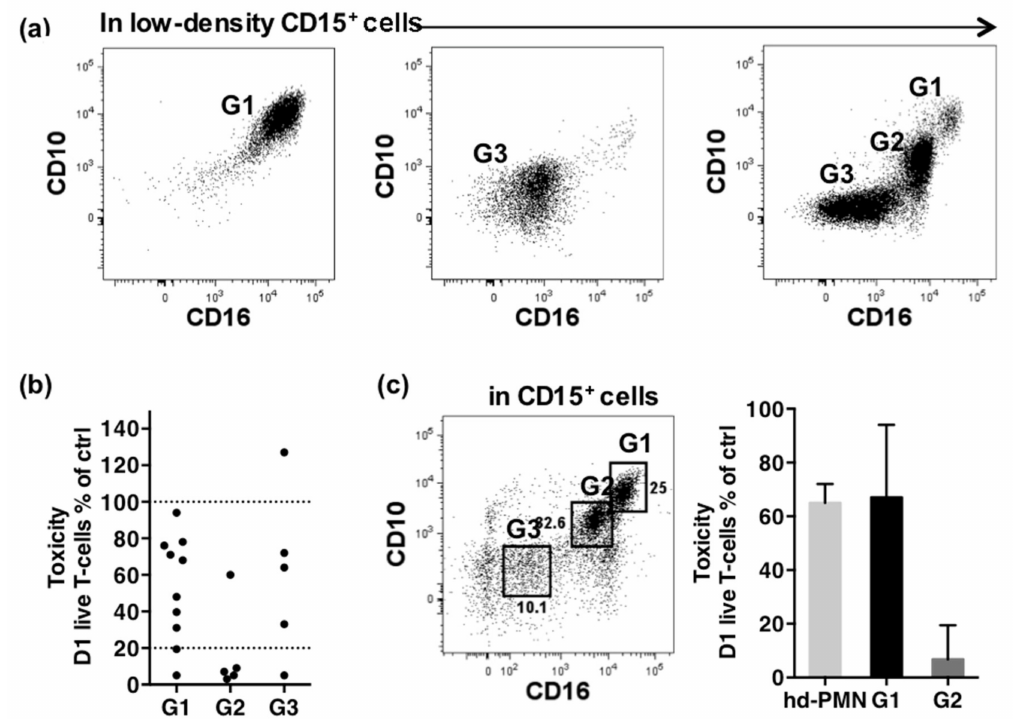
Figure 4. Matching of cytotoxicity with phenotype. ( a ) Typical CD10/CD16 profiles of PMN-MDSCs gated as CD14 − CD15 + cells in PBMCs as described in Figure 1. The CD10 high CD16 high population is named G1, the CD10 int CD16 int population G2 and the CD10 − CD16 − population G3. One patient’s sample is shown as an example for each typical profile observed. ( b ) Cytotoxicity according to the major subset present in CD15 + cells. 100% and the threshold of 20% are shown as dotted lines. Samples grouped as G1 contained on average 84% of G1, 2% of G2 and 6.8% of G3 ( n = 10). Samples grouped as G2 contained on average 13% of G1, 48% of G2 and 29% of G3 ( n = 5). Samples grouped as G3 contained on average 6% of G1, 14% of G2 and 53% of G3 ( n = 5). ( c ) Cytotoxicity of G1 and G2 cells sorted by FACS from the PBMCs of a patient sample. Cytotoxicity of high-density PMNs of the same patient is shown (for each cell-type, 1 sample in